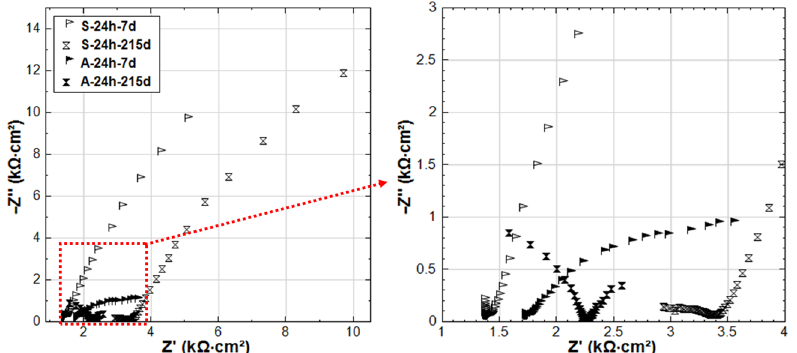
Figure 13. EIS responses overlay in Nyquist format of S-24h and A-24h (S-24h: Stray Current, A-24h: Anodic Polarization, 24h-cured specimens treated in water) at age of 7d and 215d.